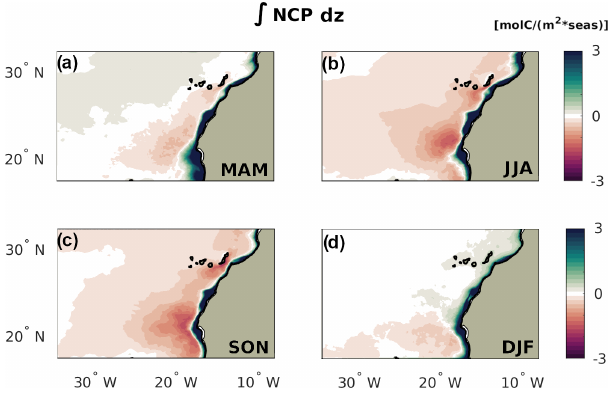
Figure 9. NCP by season integrated across the entire water column. Positive regions are net sources of organic carbon, permitting these regions to export C org . Negative regions remineralize more organic carbon than what they produce throughout the water column, re- quiring a net transport convergence of C org